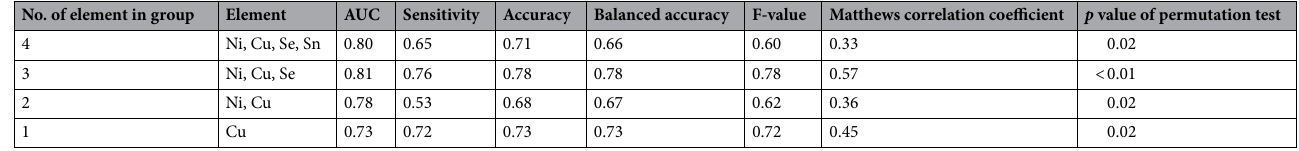
Table 5. Prediction performance of multi-element model trained by fingernail elemental contents. AUC, area under the receiver operating characteristic curve. No. of permutations: 100.